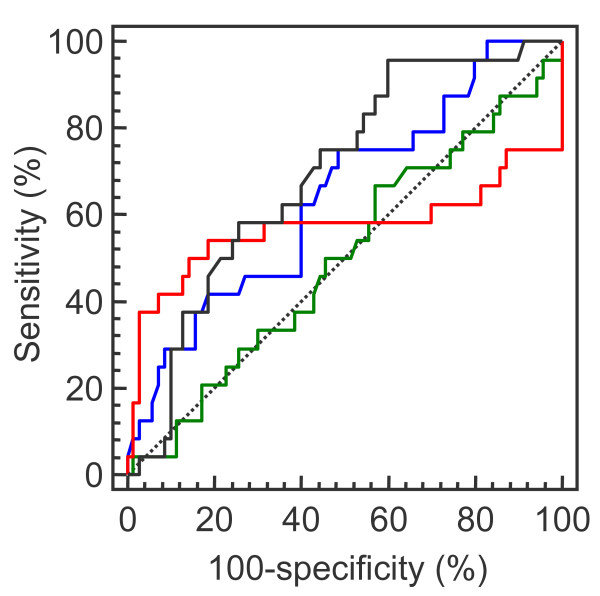
ROC curves for tPSA (green, AUC 0.5), %fPSA (blue, AUC 0.64), PSAD (black, AUC 0.69) and ANNV (red, AUC 0.57) to show the different behavior of the curve regardless of the AUC at tPSA 4–10 ng/mL (PSAV and ANN not shown, given in table 4).